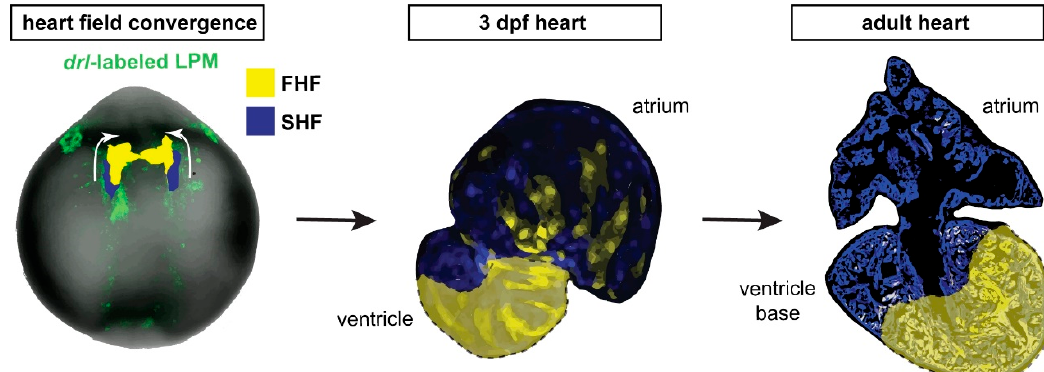
Figure 5. draculin (drl ) - based FHF lineage tracing of cardiomyocytes reveals compartmentalization of the adult zebrafish ventricle. Model summary of the reported findings. FHF and SHF descendants in the anterior LPM (ALPM) form the early-differentiating and late-differentiating myocardium, respectively, in the early heart. Then, in the adult heart, the FHF myocardium predominantly contributes to the atrium-distal portion of the ventricle including the apex, whereas the atrium-proximal region of the ventricle base is predominantly SHF-derived. Nonetheless, the interface between the FHF and SHF regions is not a sharp compartment boundary.